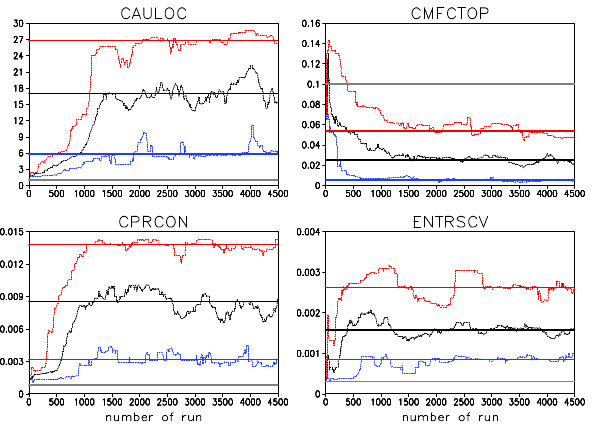
Fig. 3. A demonstration of how the MCMC posterior distribution converges with increasing chain length for the J G + ZONAL objec- tive function. The dotted blue, black and red lines show the 10th, 50th and 90th percentiles of the posterior distribution for the previ- ous 500 runs (or for all runs performed so far, for runs 1–499). The horizontal blue, black and red lines indicate the 10th, 50th and 90th percentile of the posterior distribution computed using the last 3500 runs (i.e, runs 1001–4500) of the chain. The horizontal grey lines indicate the default values of the parameters.